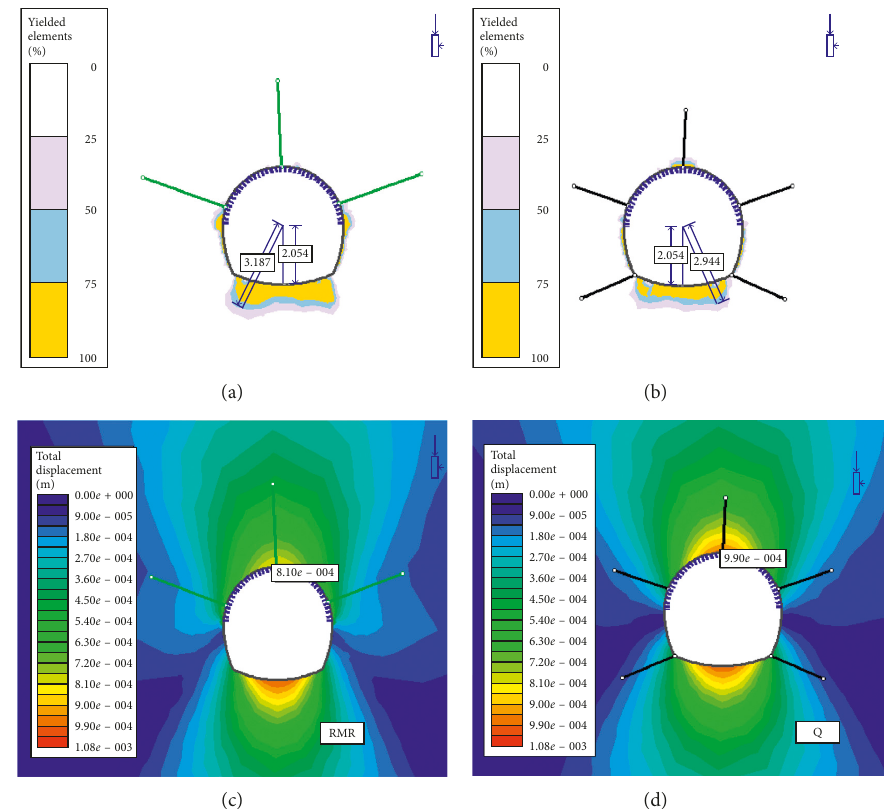
Figure 7: Yield elements and yield zone (50%) after RMR (a) and Q (b) supports. Total deformation after RMR (a) and Q (d)